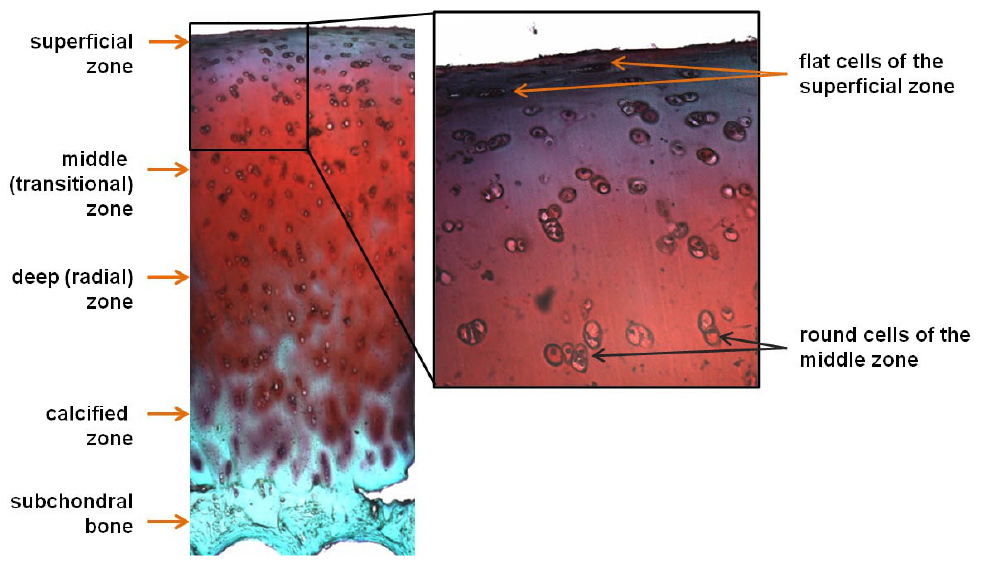
Figure 1. Structure of human articular cartilage. Articular cartilage from a 57-year-old man is stained with Safranin O/Fast Green (images were made by E. V. Medvedeva).